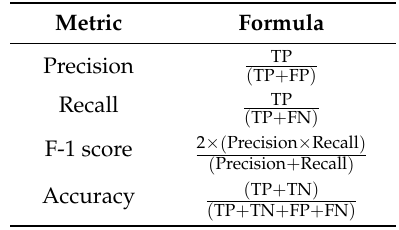
Table 7. Classifier model performance